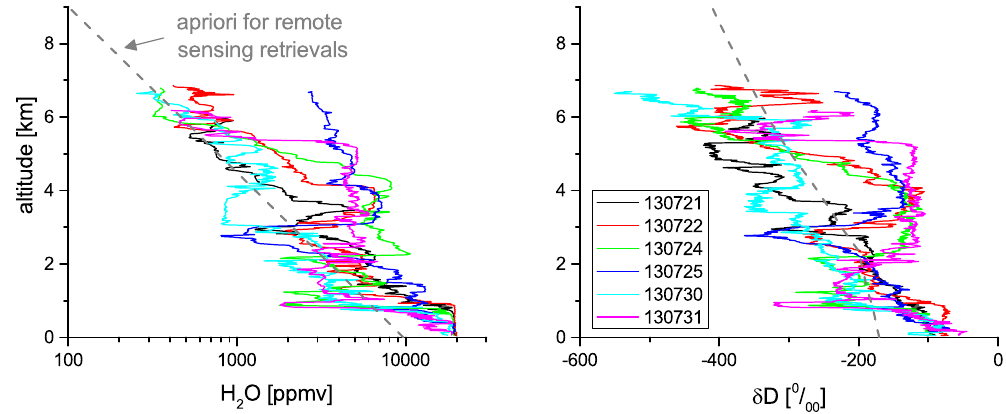
Figure 1. H 2 O (left panel) and δ D profiles (right panel) as measured by ISOWAT above the subtropical Atlantic close to Tenerife between 10:00 and 13:00UT on 6 days at the end of July 2013. The depicted data are 10m vertical averages. For comparison we also depict the a priori profiles used for the MUSICA NDACC/FTIR and METOP/IASI remote sensing retrievals (grey dashed